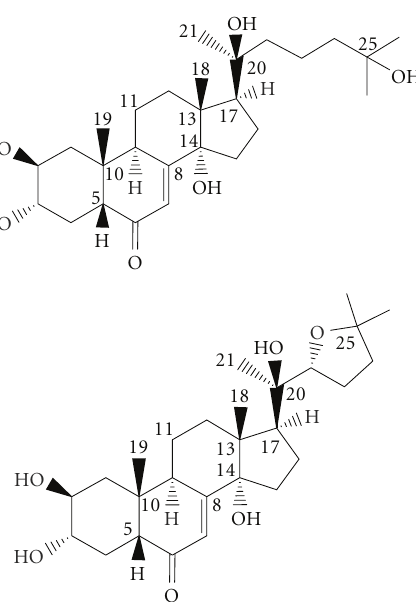
Figure 1: Proposed structures and numbering scheme for 1 (top), 2 (middle) and 3